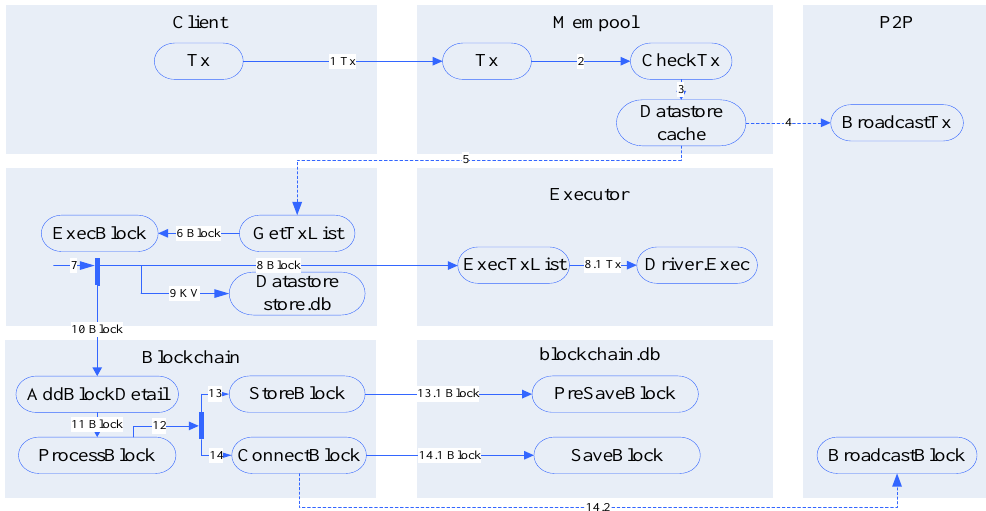
Figure 3. Consensus mechanism of consortium chain based on blockchain.